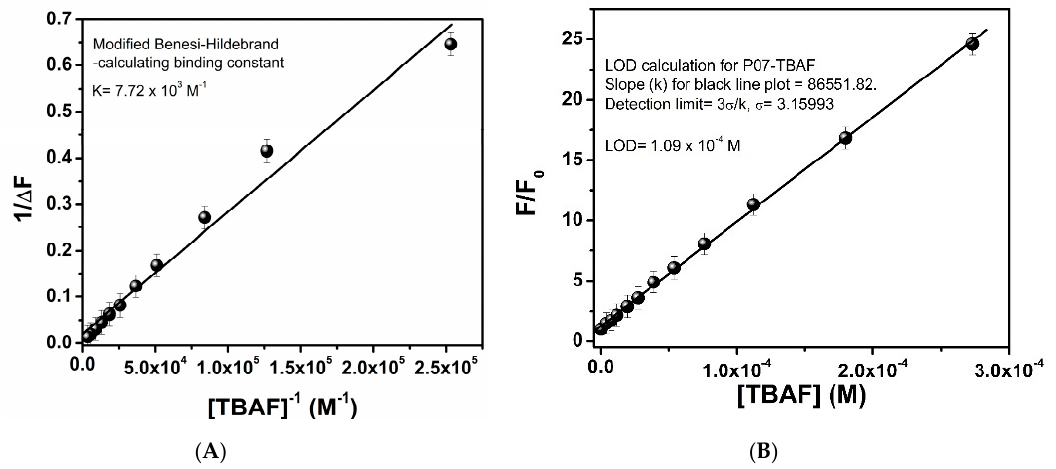
Figure 7. Analysis of the P07 -fluoride interaction with ( A ) a Benesi–Hildebrand plot and ( B ) a calibration curve.